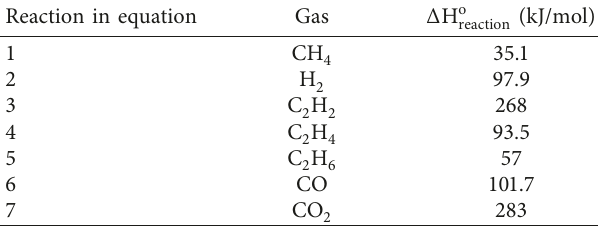
Table 2: Calculated enthalpies of the fault